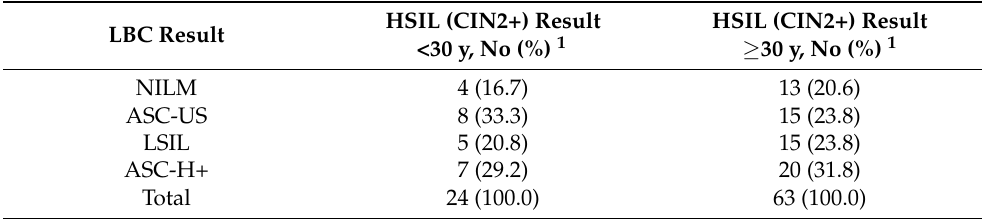
Table 2. Age-stratified LBC reporting rates (<30 and ≥ 30 years) in cases with HRHPV14, LBC, p16/Ki67 and histology results—the final study group selection.